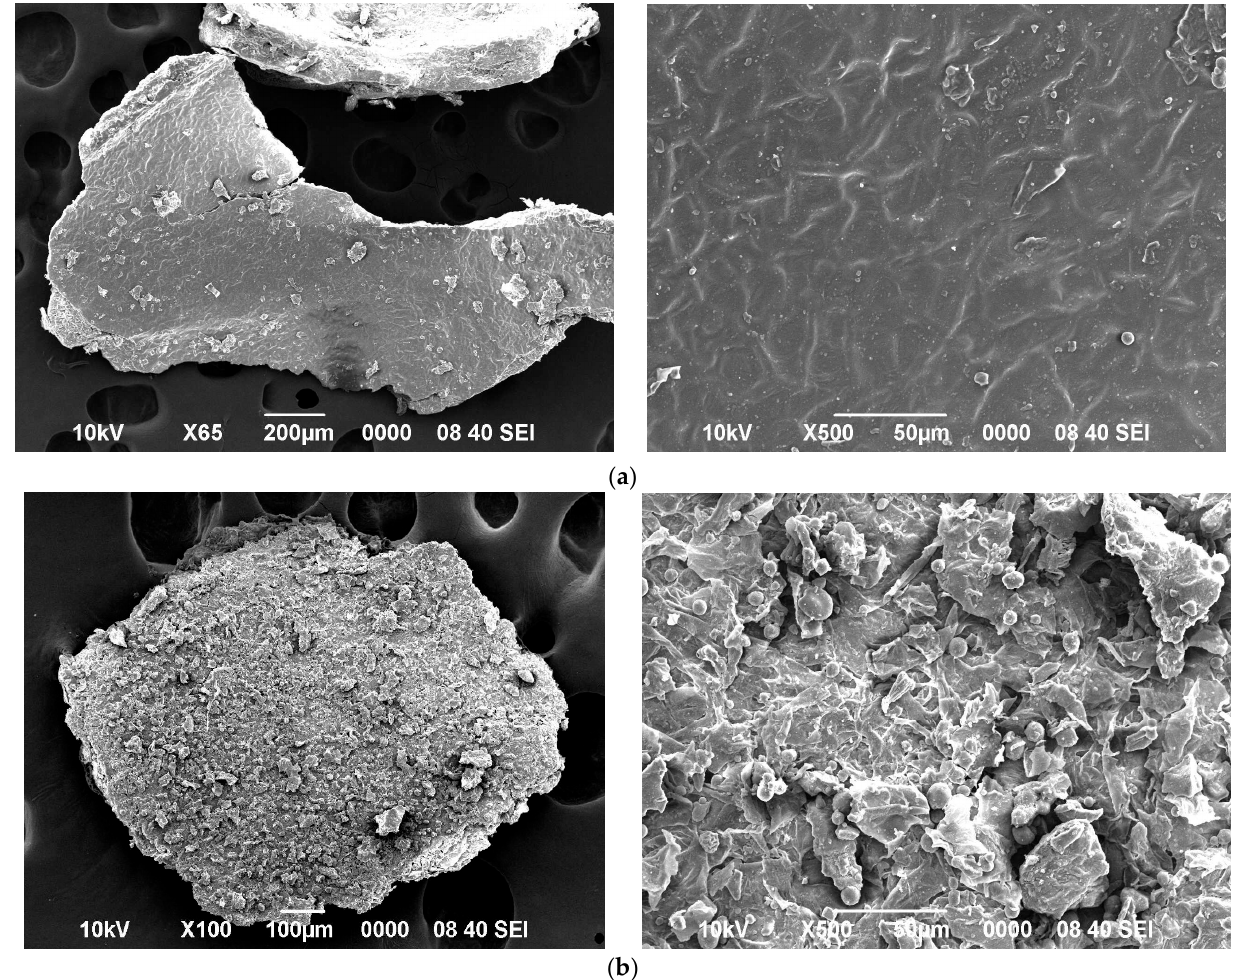
Figure 4. SEM Micrograph of roselle before ( a ) and after ( b ) ScCO 2 extraction.